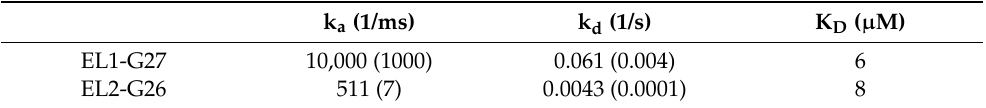
Table 2. Association and dissociation rates, dissociation constant K D : Gap peptides were injected over a surface with captured RadA-scaffolding protein, and the responses to dilution series were fitted to a 1:1 binding model. Fitted standard errors shown in